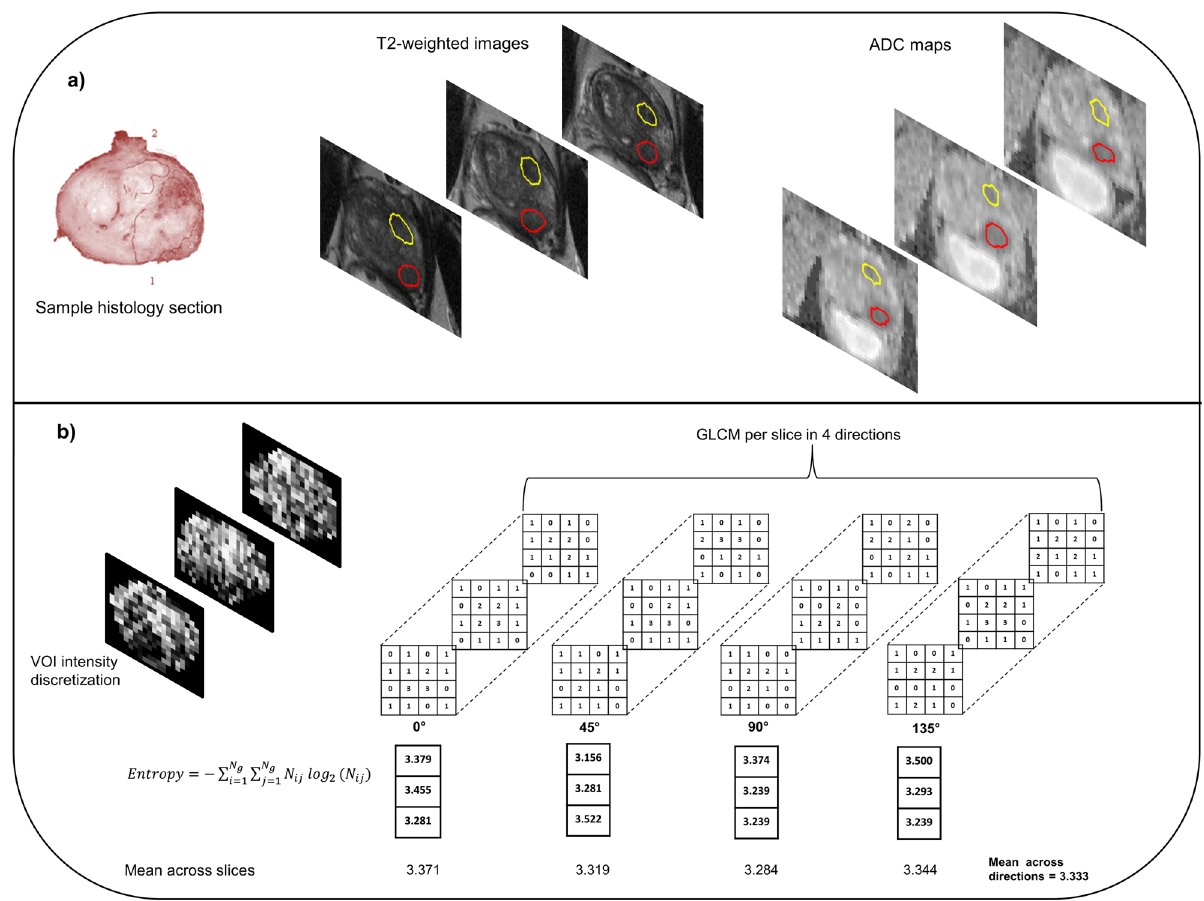
Figure 1. Illustration of tumor volume-of-interest (VOI) delineation and grey level co-occurrence matric (GLCM) texture feature extraction. ( a ) Histopathology slides were visually matched to the T 2 -weighted (T 2 W) images using anatomical landmarks. Peripheral (red) and transition (yellow) zone tumors were manually outlined on the T 2 W images based on their location on histology and appearance on T 2 W images, and then transformed to corresponding apparent diffusion coefficient (ADC) maps via registration or manually if the registration was deemed suboptimal. ( b ) Textural feature extraction from T 2 W VOIs using 2D average approach. For illustration purposes, the number of grey level bins was limited to four in this schematic, instead of the 32 used in actual